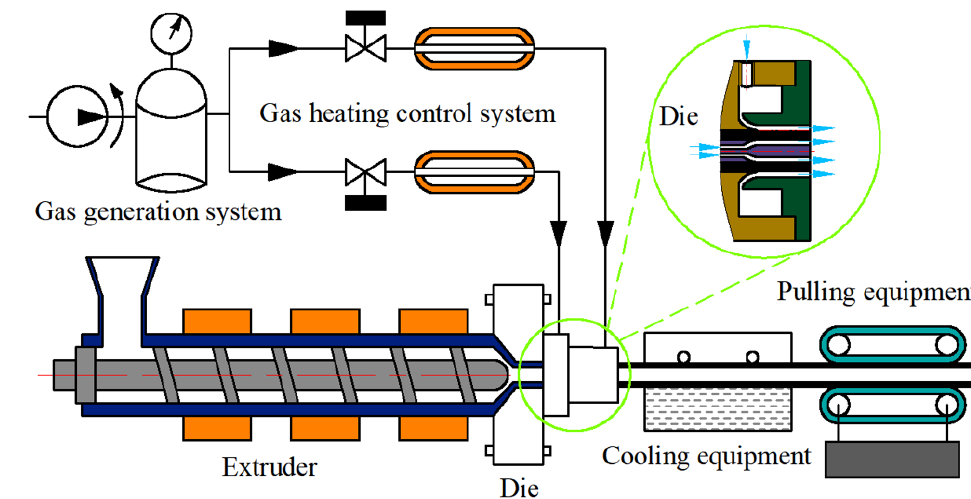
Figure 9. Gas-assisted extrusion experimental equipment.